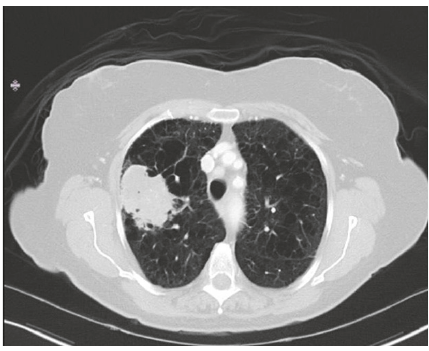
Figure 3: CT chest showing right upper lobe mass with